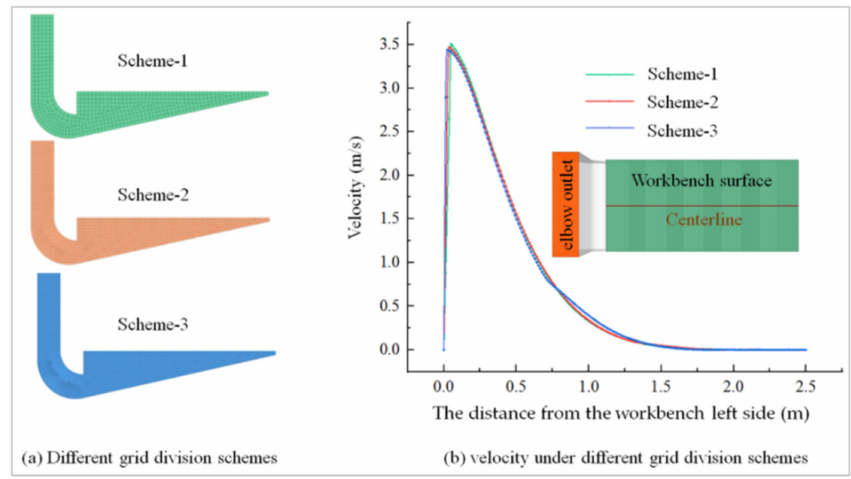
Figure 5. Variation of air velocity under different grid division schemes for Structure-1.